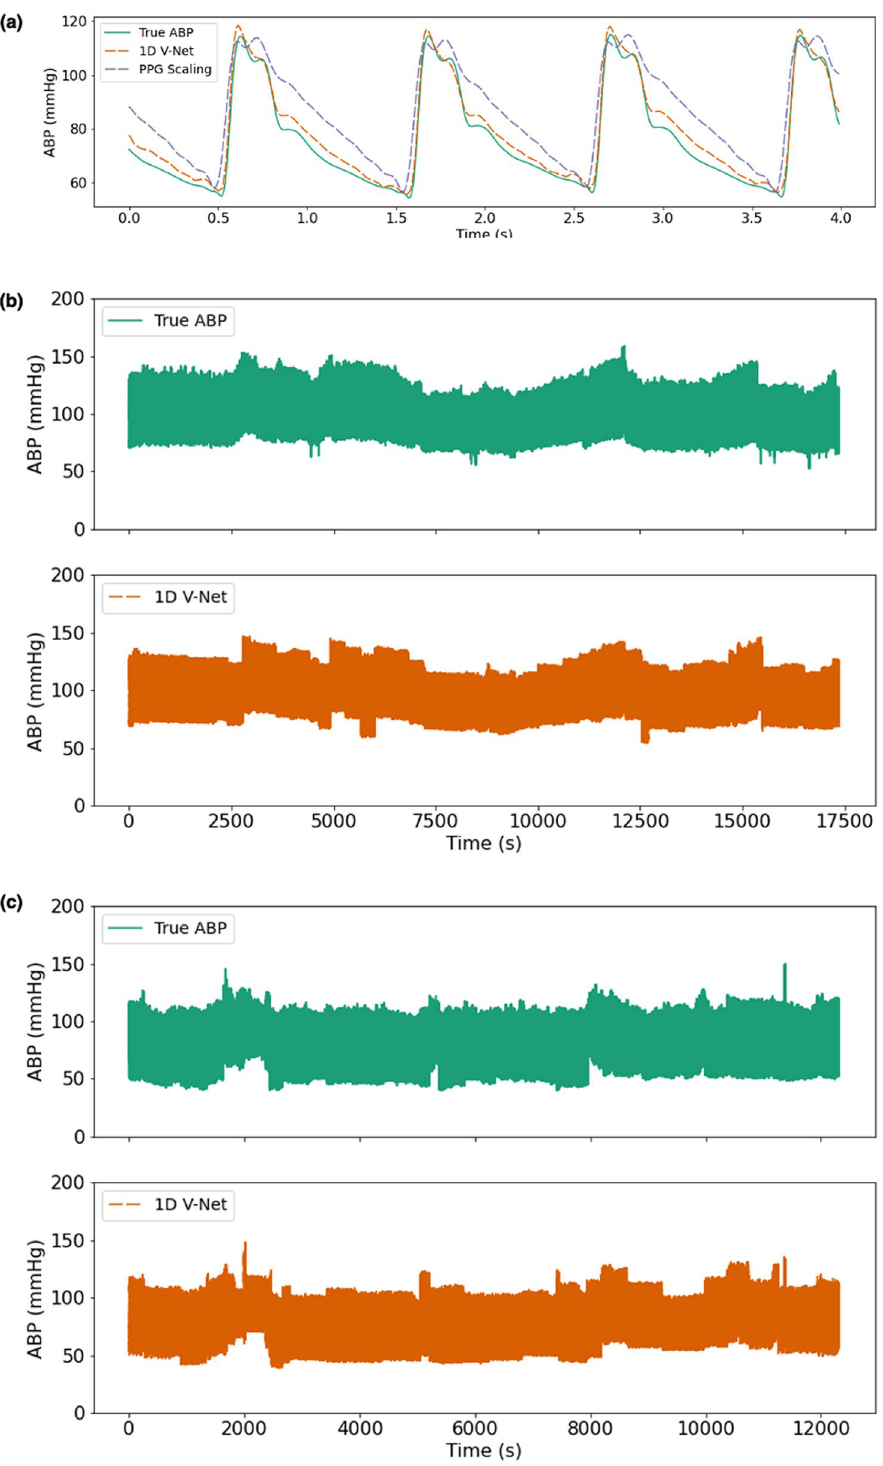
Figure 2. Example ground truth & predicted waveforms. ( a ) 4-s window (for the input data shown in Fig. 1) and > 3 h records ( b , c ). The true continuous blood pressure waveform is shown above in green, and the predicted blood pressure waveform shown below in